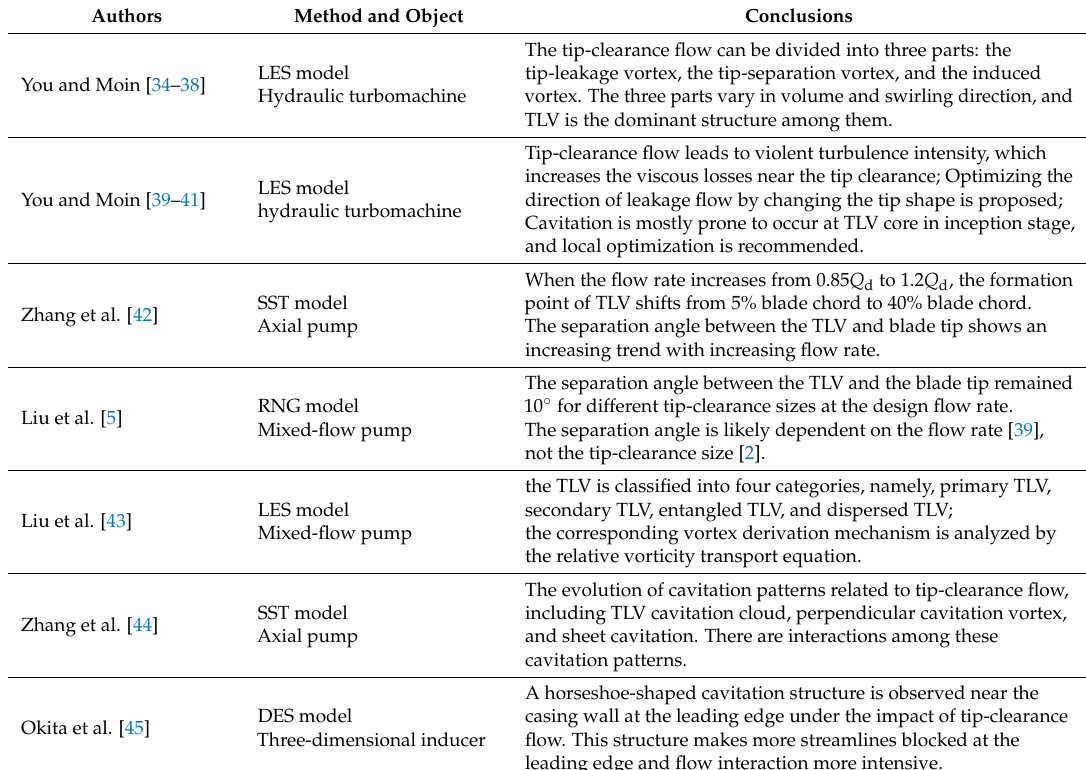
Table 3. Main numerical studies on tip-clearance